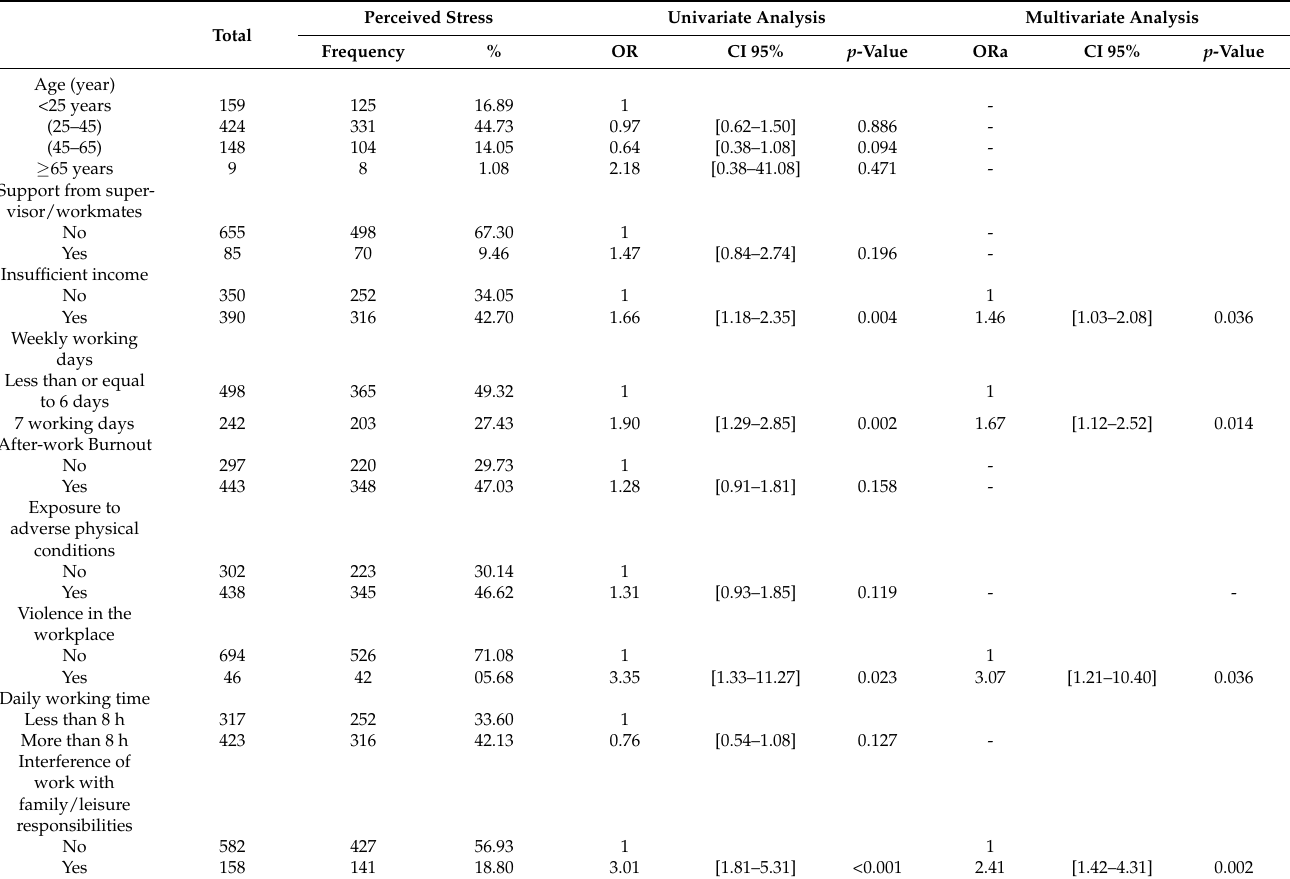
Association between perceived stress and selected occupational factors related